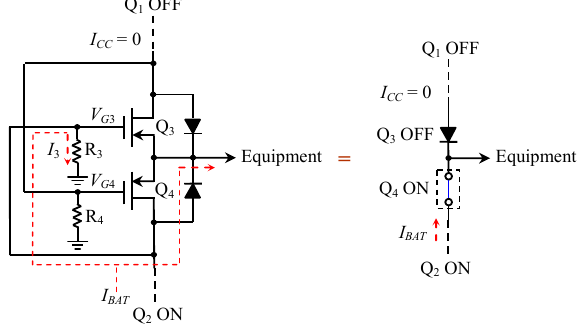
Figure 9. Mutual blocking when the main power supply is restored. Figure 7. Mutual blocking when the main power supply is restored.